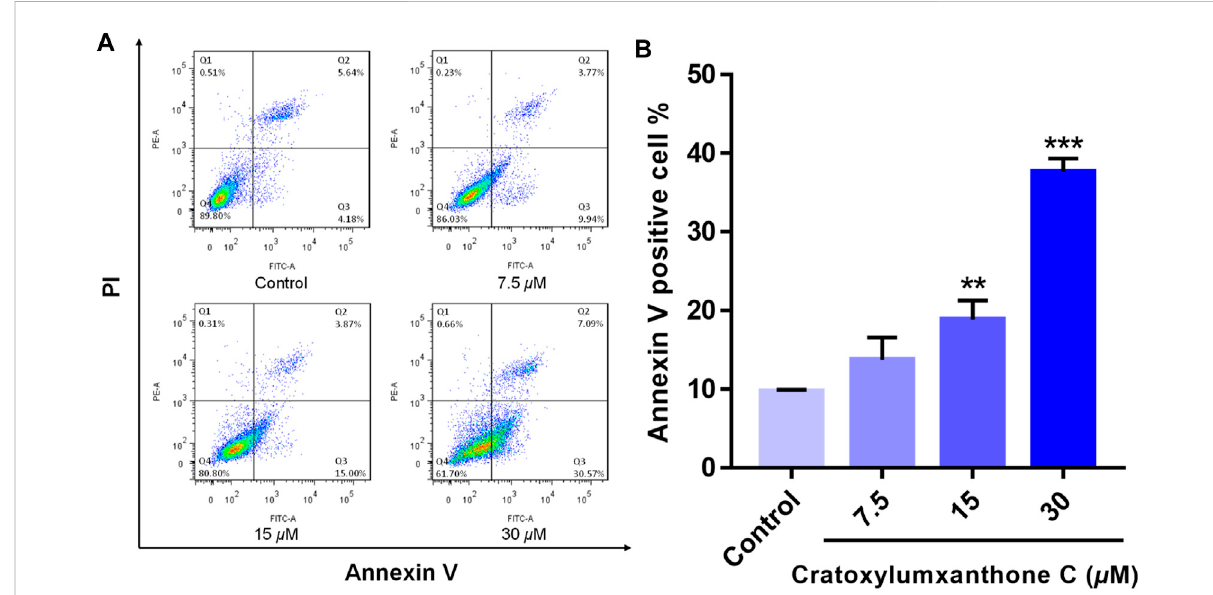
FIGURE 3 Cratoxylumxanthone C induced apoptosis in A549 cells. A549 cells were treated with different concentrations (7.5, 15, and 30 μ M) of cratoxylumxanthone Cfor 48 h.Cellswerestained with AnnexinV andpropidiumiodide (PI),and subsequentlyanalyzed by fl owcytometry. (A) Flow cytometric analysis ofA549 cells after treatedwith differentconcentrationsofcratoxylumxanthoneC. (B) Histogramoftheproportions ofapoptotic cells at 48 h with the treatment of cratoxylumxanthone C. The results are expressed as means ± SD. **p < 0.01 and ***p < 0.001 versus control group.